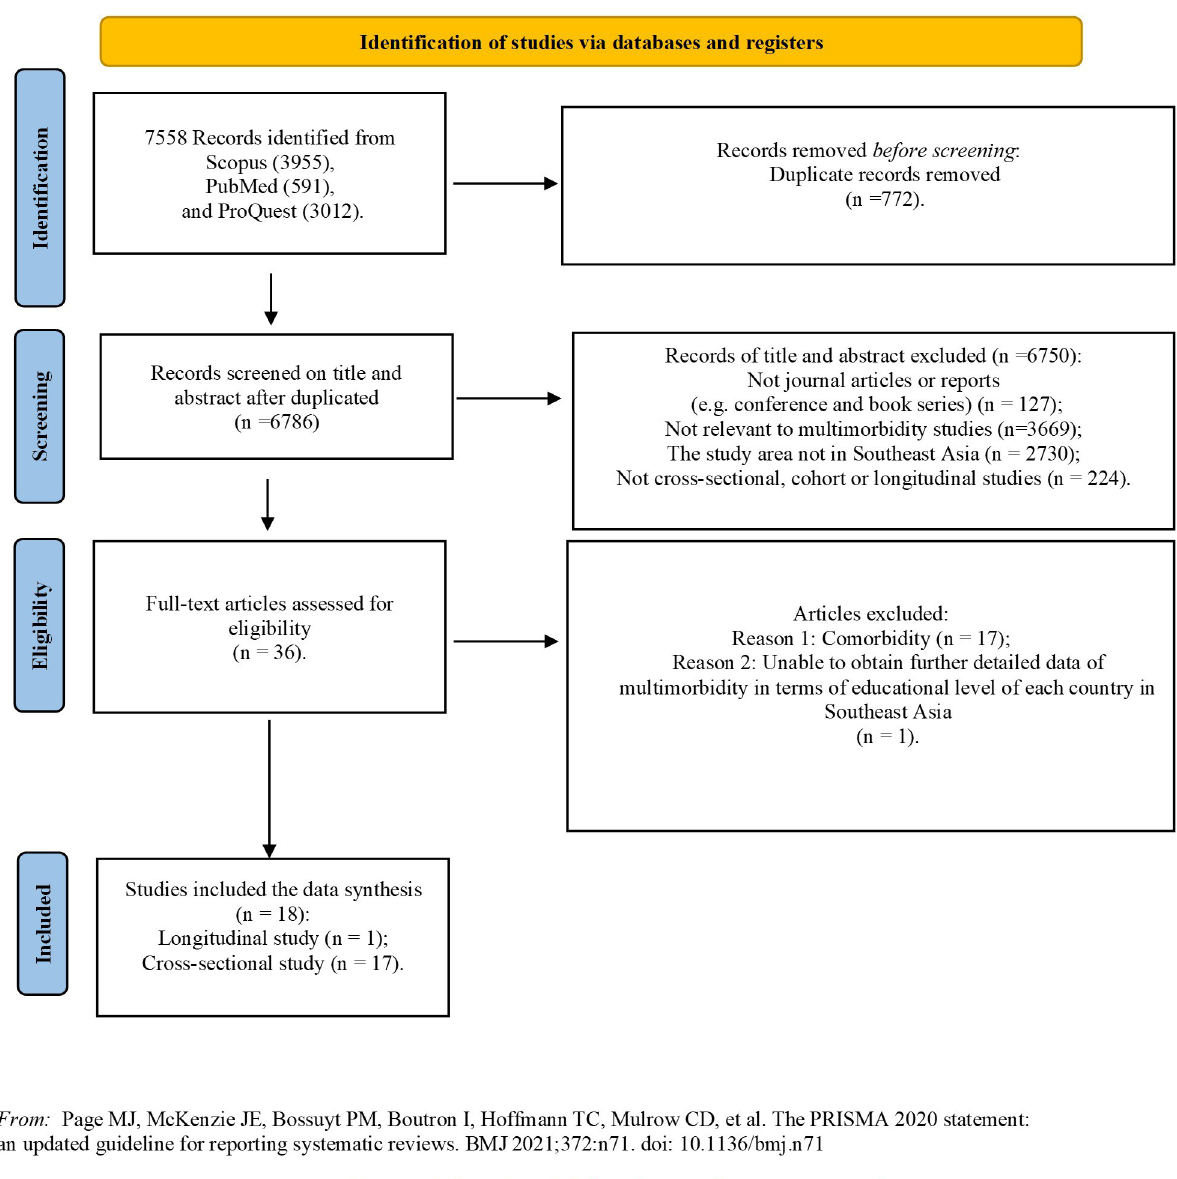
Fig 1. PRISMA flow diagram. Description of article selection